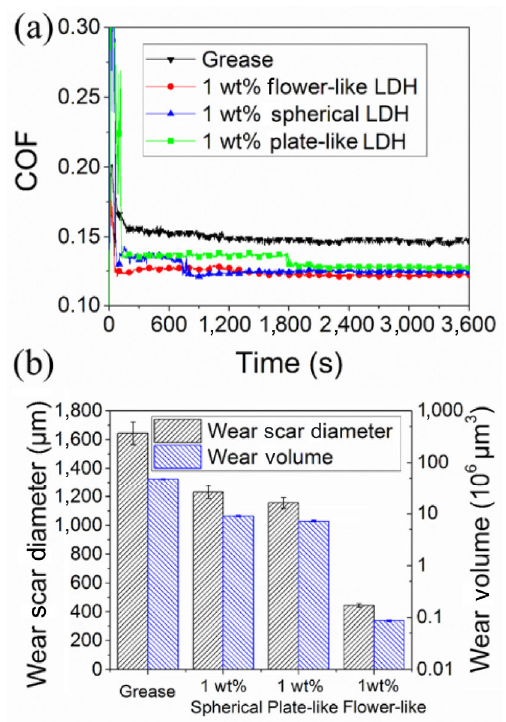
Fig. 4 (a) Friction coefficient and (b) wear condition of 1 wt% MgAl–LDHs with different morphology (flower-like, spherical, and plate-like) in base grease.